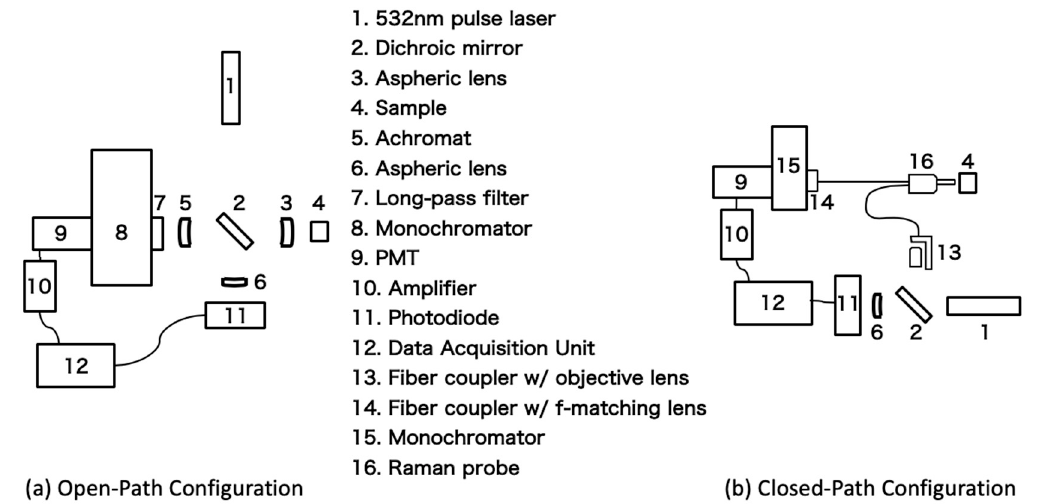
Figure 7. Schematic layout of 532 nm Time-Resolved Raman Spectroscopy System (TRRS) configuration.